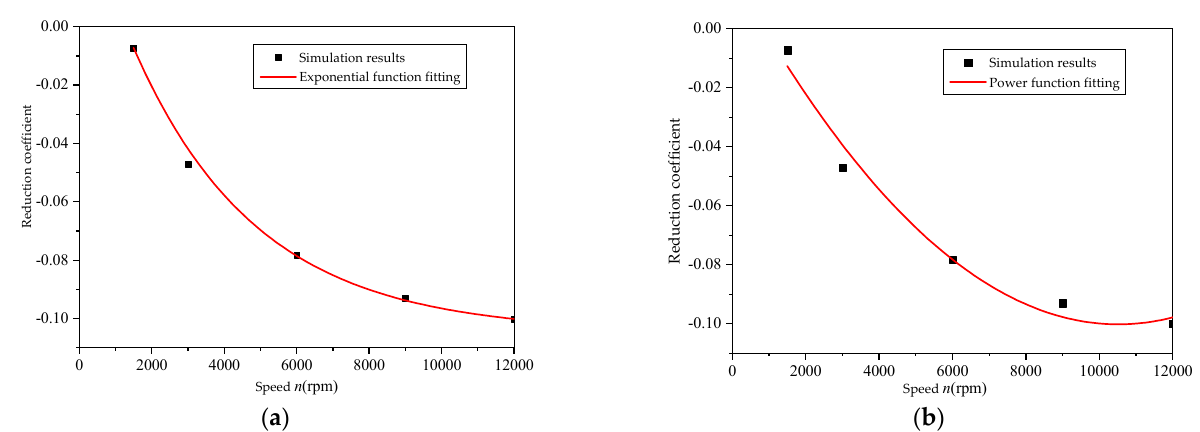
Figure 9. The variation law of the reduction coefficient with rotational speed: ( a ) exponential function fitting and ( b ) power function fitting.